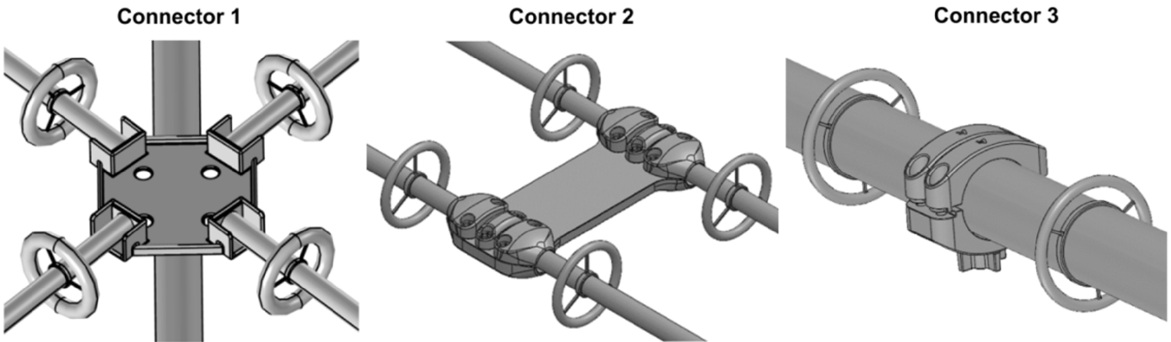
Figure 3. Connector with rings installed around the conductors.